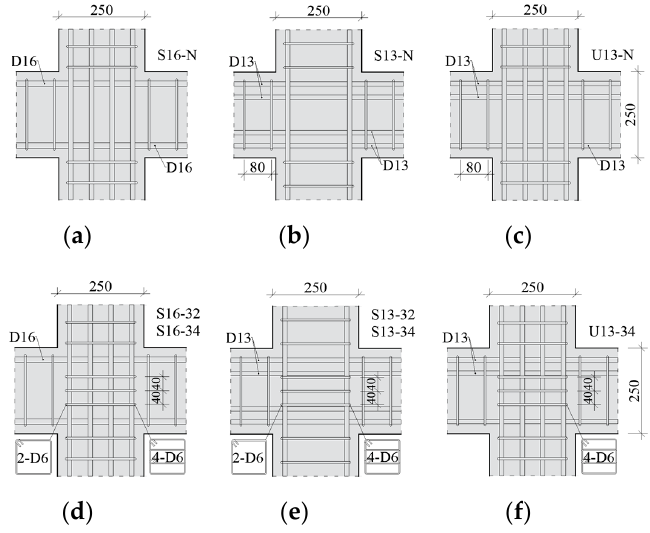
Figure 2. Details of joint shear reinforcements (unit in mm).